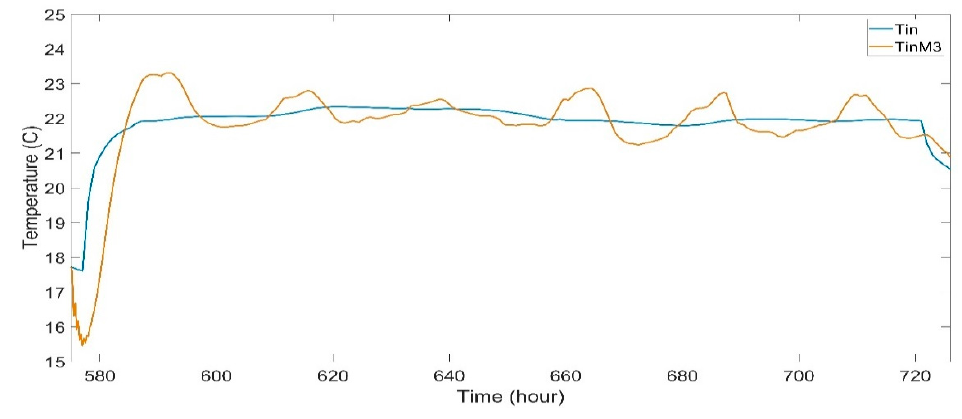
Figure 13. Comparison between the simulated indoor temperature and measured data for the real building by means of Model M3.